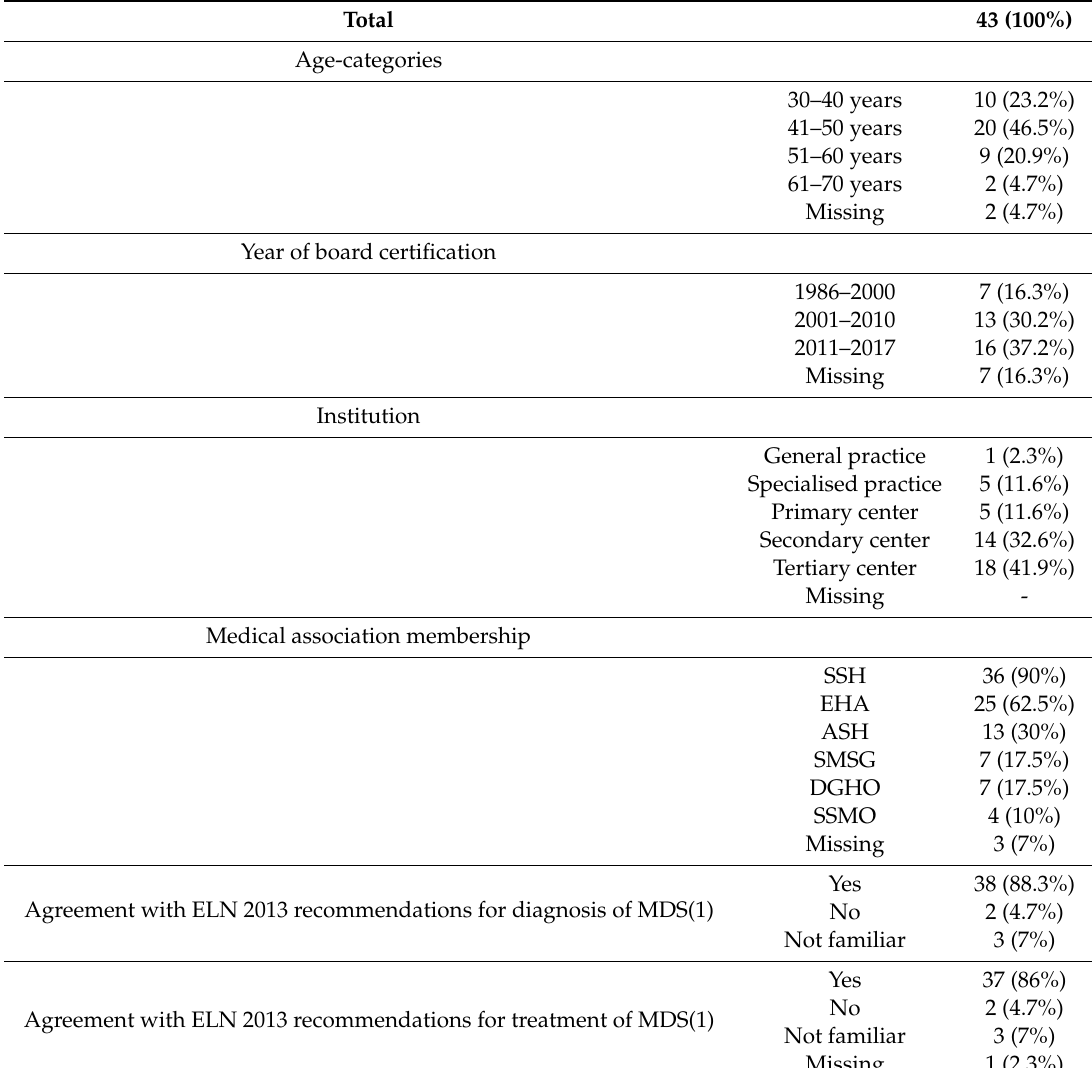
Table 1. Characteristics of